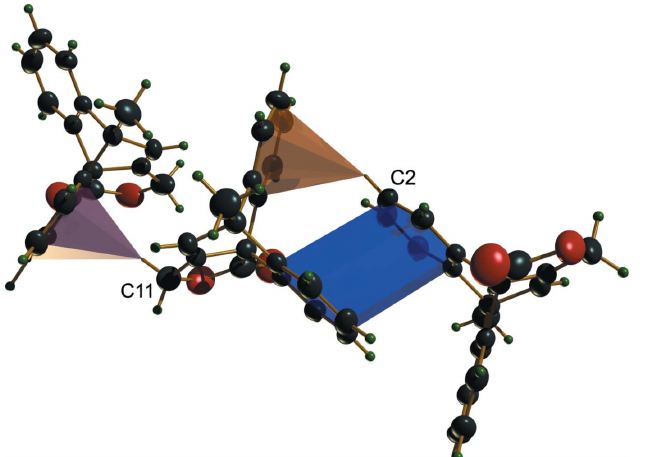
Figure 1 The molecular structure of the title compound, with atom labels and 50% probability displacement ellipsoids for non-H atoms.